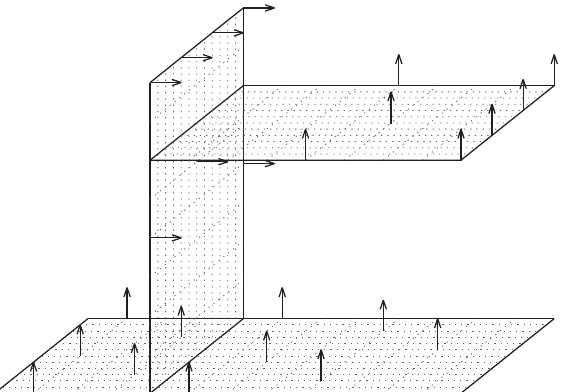
Figure 5: Scenario with 25 active DOFs according to the